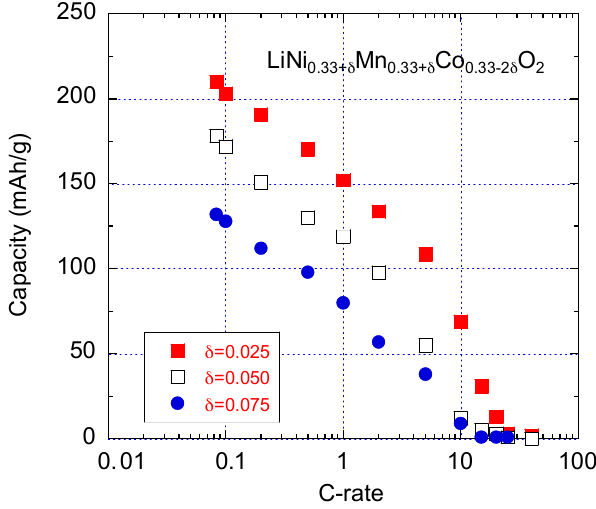
Figure 19. Peukert plots for Li//LiNi 0.33+ δ Mn 0.33+ δ Co 0.33-2 δ O 2 cells.